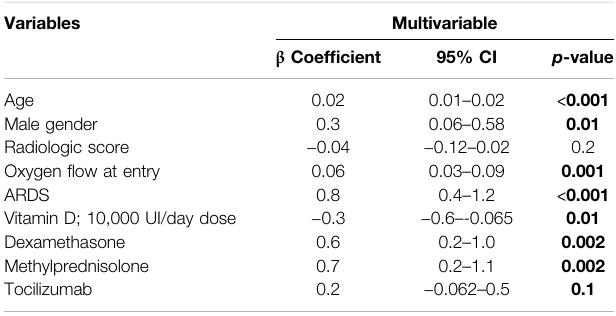
TABLE 3 | Multivariable analysis predicting factors associated with the length of hospital stay (LOS) in hospitalized patients with COVID-19. Variables